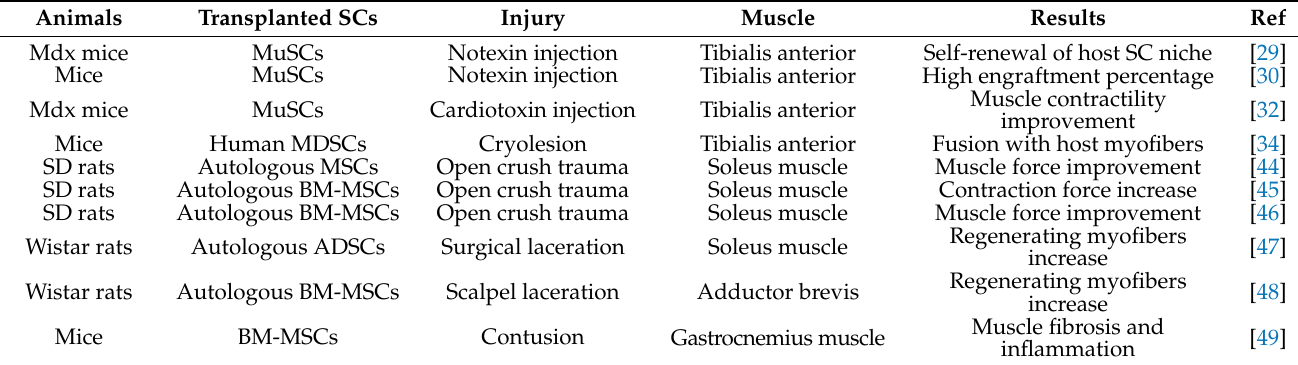
Table 1. Potential SC therapies for skeletal muscle regeneration. In vivo